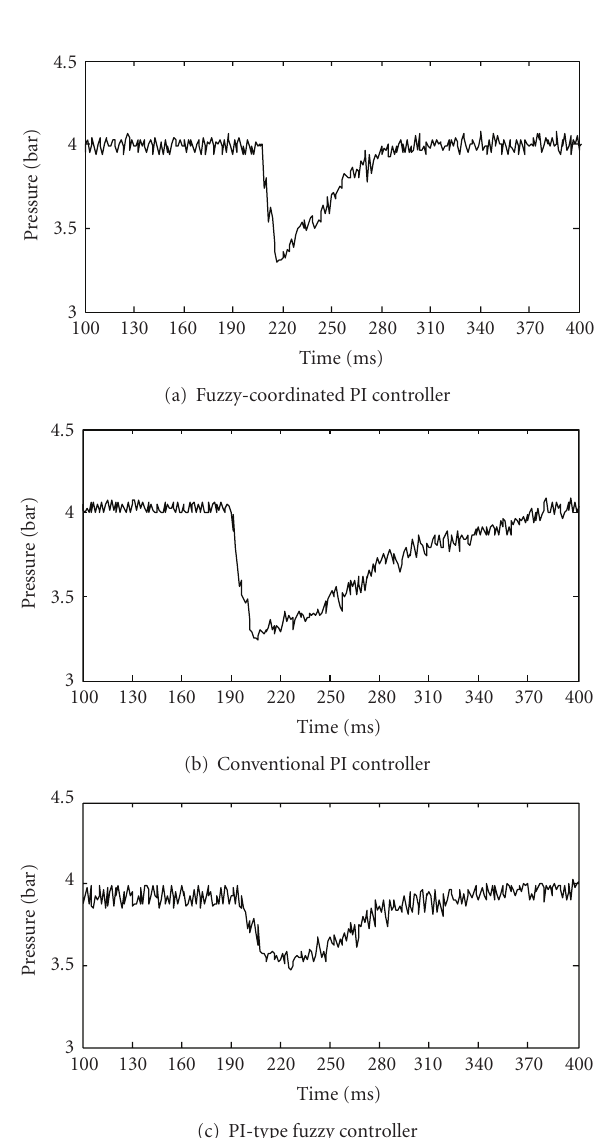
Figure 15: Experimental results, load disturbance response of controllers for decreasing the process